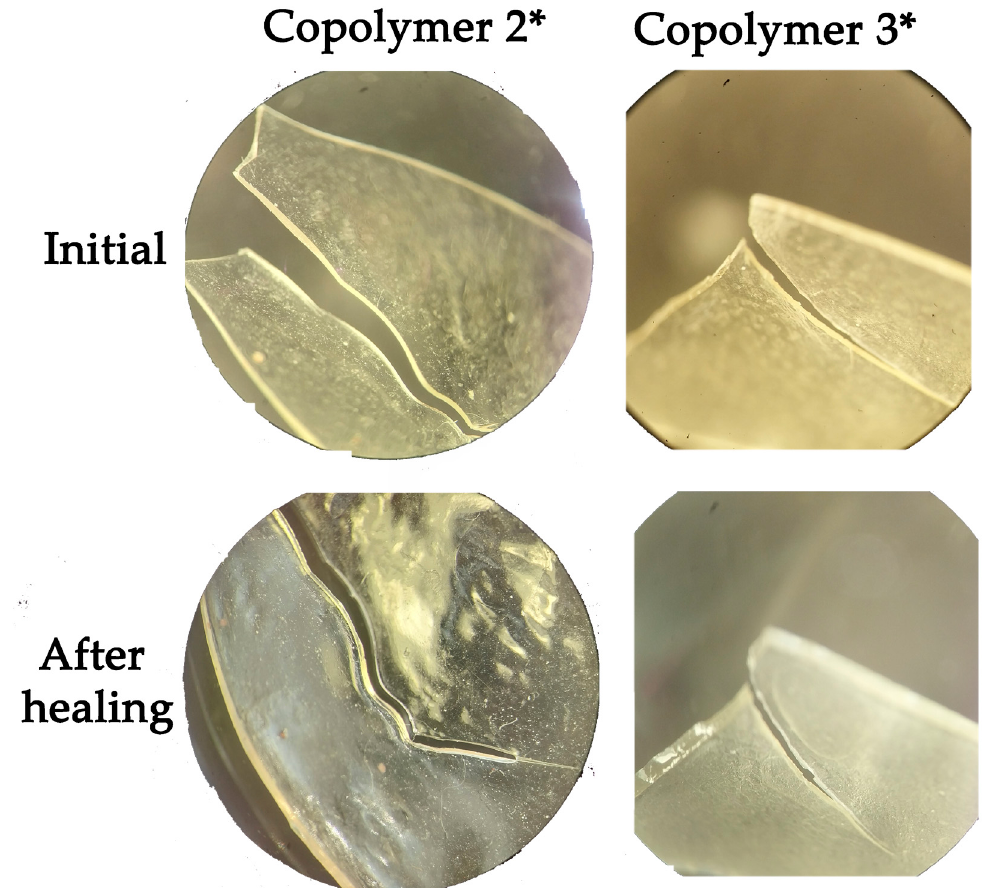
Figure 15. Optical microscopic images of autonomous internal healing of acrylamide and acrylic acid copolymers (copolymer 2*—AAm:AAc = 50:50 without CoAcr 2 PhTpy, copolymer 3*—AAm:AAc = 15:85 without CoAcr 2 PhTpy).